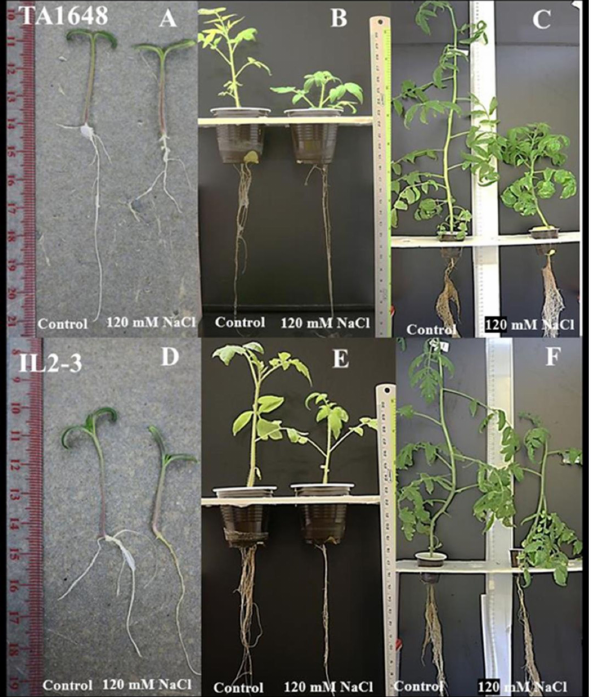
Figure 2. Salt tolerance evaluation in tomato genotypes under control and salt stress (120 mM NaCl). TA1648 and IL2-3 introgression lines at: Germination stage ( A , D ), seedling stage ( B , E ), and vegetative stage ( C , F ), respectively. The hydroponic growing system used for salt stress tolerance